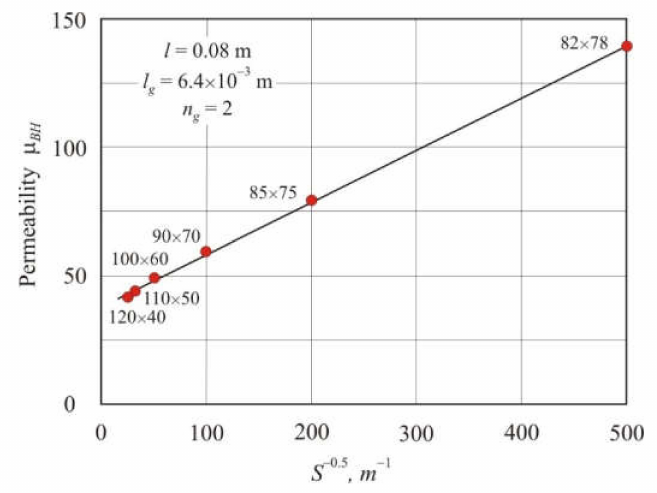
Figure 7. Dependence of the effective permeability µ BH on S − 0.5 in soft magnetic annuluses with two air gaps, the mean magnetic flux length l = 0.08 m and the total air gap length l g = 6.4 × 10 − 3 m. Core dimensions are shown near points.